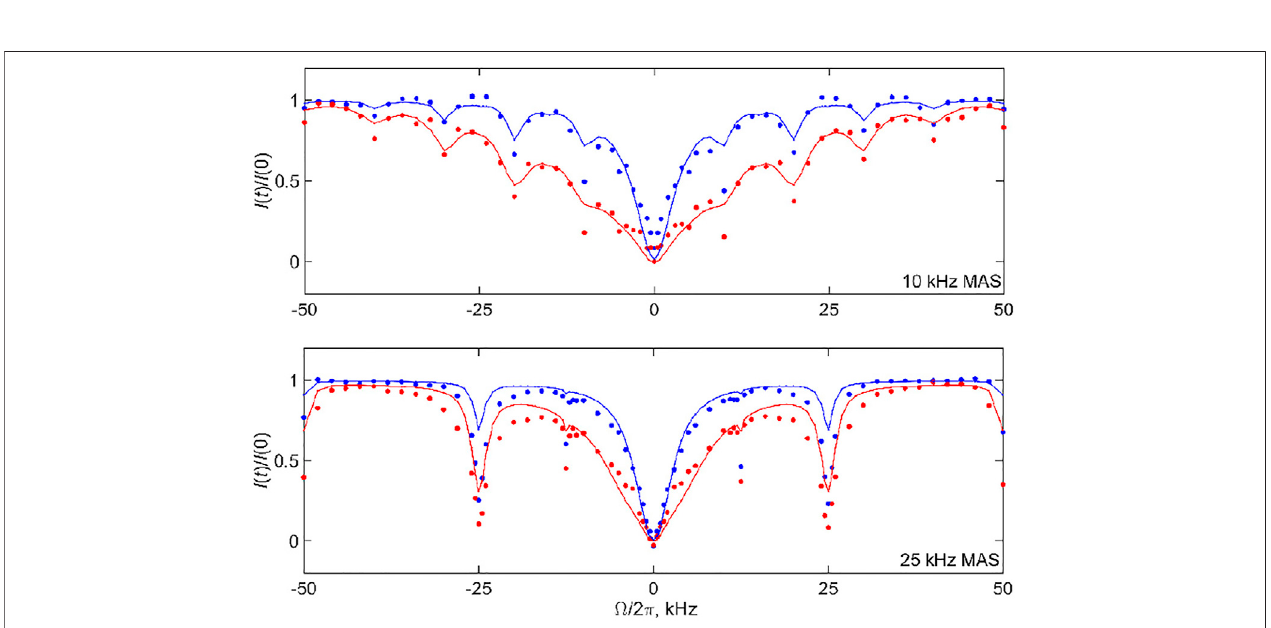
FIGURE 12 | 2 H CEST pro fi les of the A β 1-40 fi brils labeled at the A2-CD 3 side chain corresponding to the intensities of all the bands (shown in the spectra of Figure 2 ) at the 10 and 25 kHz MAS rates. The experimental normalized integrated summed intensities of all the bands I ( t )/ I (0) versus resonance offsets Ω / 2 π for ω / 2 π (cid:2) 1.3 kHzand T (cid:2) 3 ms(bluecircles) and T (cid:2) 20 ms(redcircles).Thelinesrepresentthebest fi ttothedataaccordingtothemodelof Figure3B withthefollowing RF parameters: 10 kHz MAS rate ( D (cid:2) 1.7 · 10 6 rad 2 /s, k ex (cid:2) 5 · 10 4 s − 1 ) for T (cid:2) 3 ms and ( D (cid:2) 1.7 · 10 6 rad 2 /s, k ex (cid:2) 1 · 10 5 s − 1 ) for T (cid:2) 20 ms; 25 kHz MAS rate ( D (cid:2) 1.0 · 10 6 rad 2 /s, k ex (cid:2) 2 · 10 4 s − 1 ) for T (cid:2) 3 ms and ( D (cid:2) 1.7 · 10 6 rad 2 /s, k ex (cid:2) 3 · 10 4 s − 1 ) for T (cid:2) 20 ms. Data were collected at 17.6 T and 37 ° C. The effect of RF inhomogeneity with the inhomogeneity pro fi les of Figure 1B was included as described in the text.